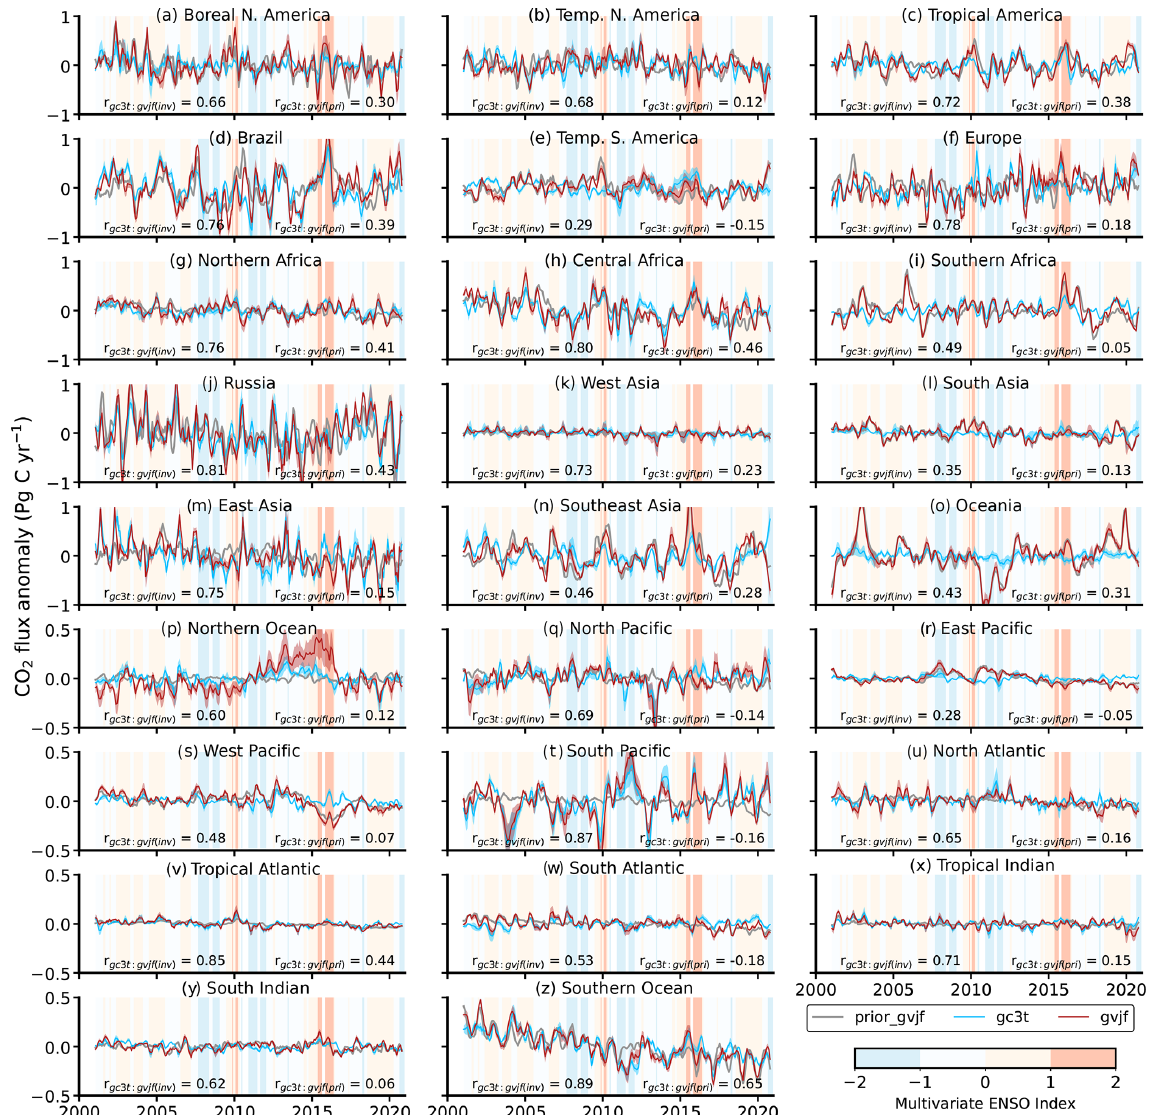
Figure 8. The 3-monthly running averages of CO 2 flux anomalies as estimated by the inversions for land and ocean regions from atmospheric CO 2 data, with varying prior flux uncertainty and different a priori emissions. The flux anomaly is calculated by subtracting an average seasonal cycle from 1999–2020 from the monthly-mean CO 2 fluxes. The cases shown in the panels are obtained by the gvjf prior fluxes (thick grey line), an average of all gc3t inversion cases, and gvjf inversion cases. The ± 1 σ around the mean of both inversion cases is shown as shading. The ENSO index is plotted in the background for the corresponding period. The correlations between fluxes (predicted and prior) and multivariate ENSO index are shown in Table